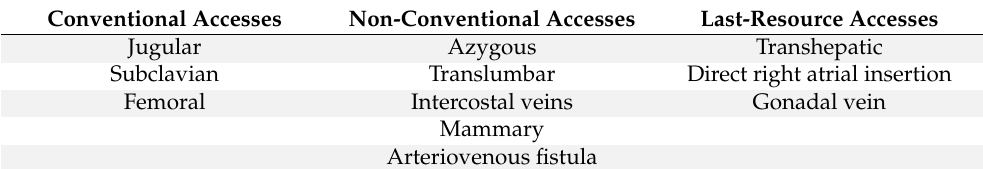
Table 3. Types of central vascular access